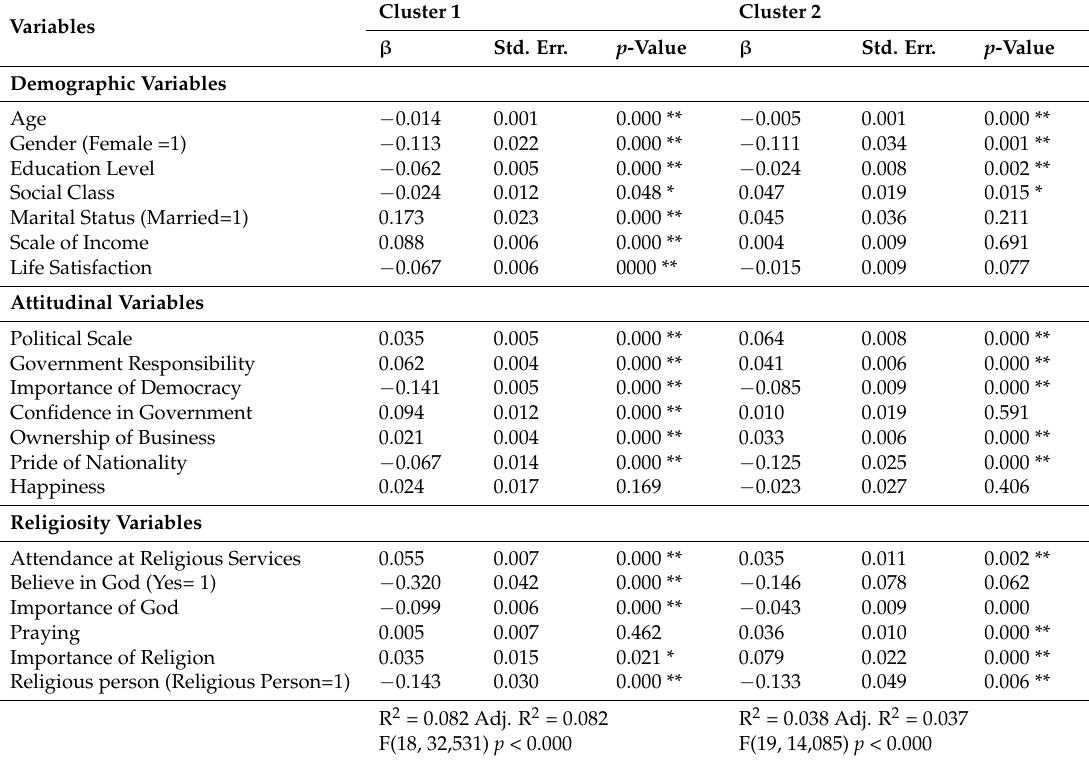
Table 4. Linear regression results of the clusters: Attitudes towards accepting